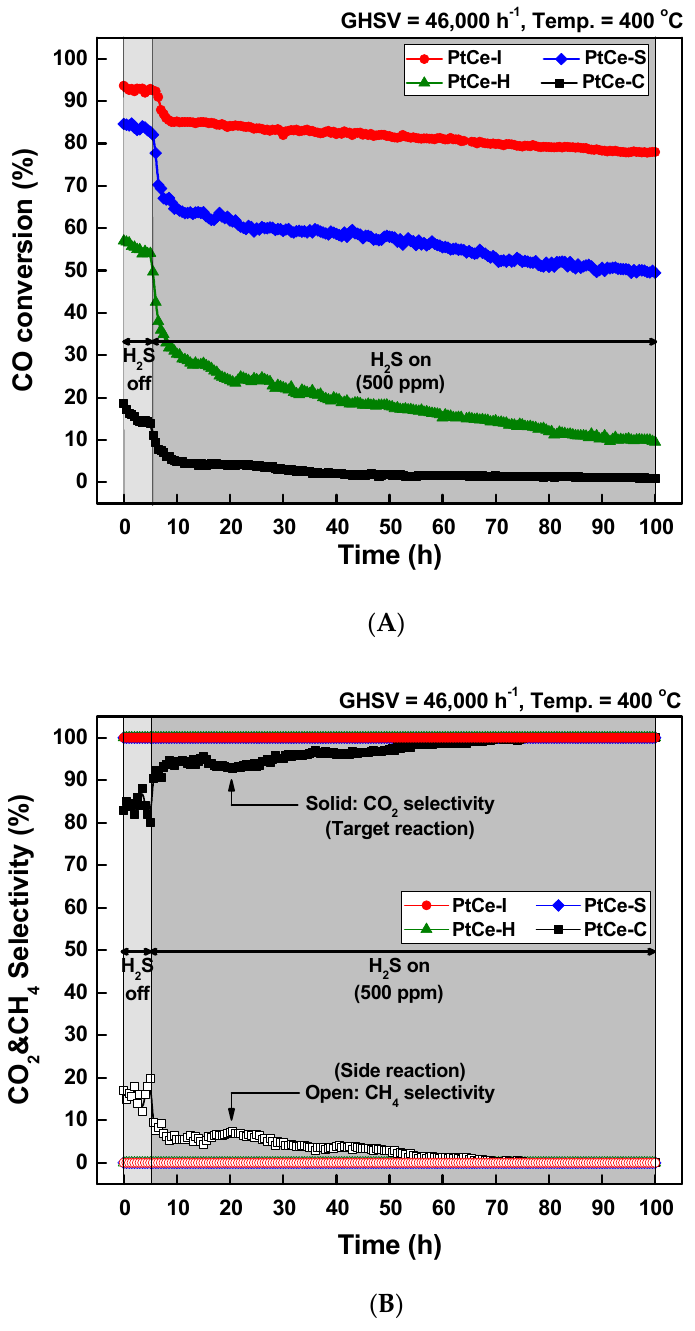
Figure 6. ( A ) CO conversion and ( B ) CO 2 and CH 4 selectivity as a function of time on stream over CeO 2 -supported Pt catalysts prepared by various synthesis methods. Table 3. Turnover frequency results over CeO 2 -supported Pt catalysts prepared by various synthesis